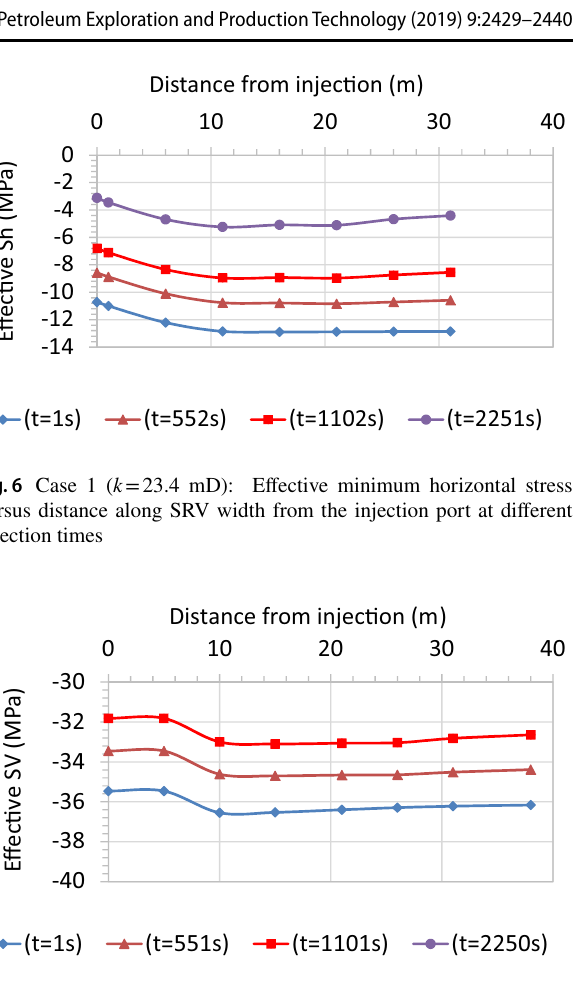
Fig. 7 Case 1 ( k = 23.4 mD): Effective vertical stress versus distance along SRV height from the injection port at different injection